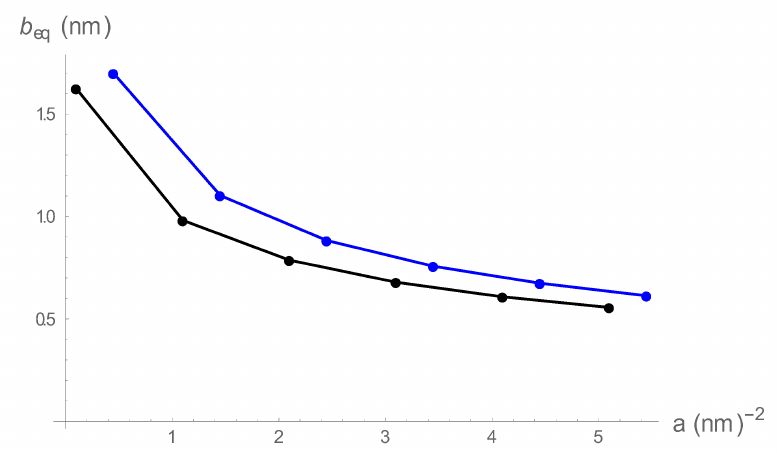
Figure 1. The equilibrium bead spacing as a function of spring constant in the counterion condensation range. The Bjerrum length is fixed at 1.7 nm, characteristic of methanol at room temperature. The 1:1 salt concentrations are 0.01 M (black), and 0.001 M